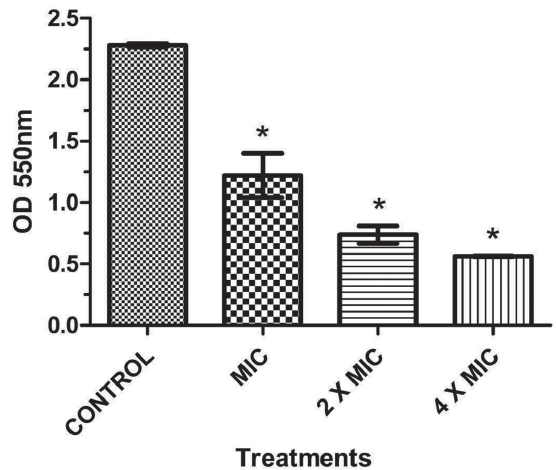
FIGURE 3 - Effects of carvacrol at MIC (312 µg mL -1 ), 2 x MIC (624 µg mL -1 ), 4 x MIC (1250 µg mL -1 ) on total biofilm